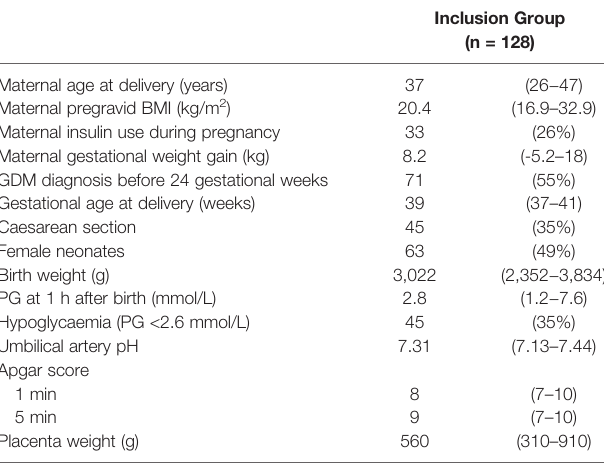
TABLE 1 | Characteristics of 128 neonates born to Japanese mothers with gestational diabetes and monitored 1 h after